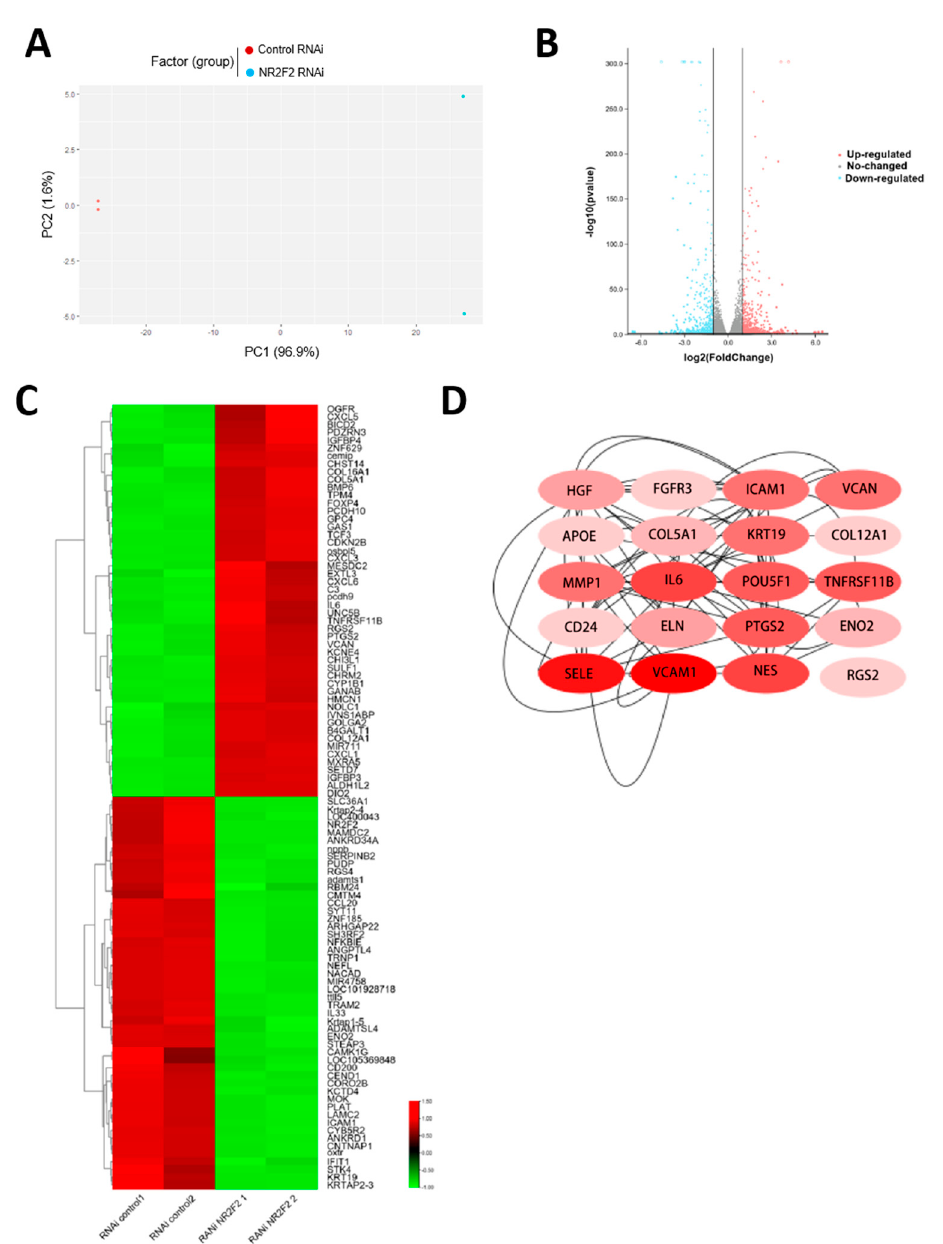
Figure 2. Global gene expression changes upon NR2F2 knockdown in WJ-MSCs. ( A ) WJ-MSCs exhibited two distinct gene expression patterns after NR2F2 was knocked down. ( B ) Each point in the volcano plot represents a gene. Red dots indicate significantly up-regulated genes, blue dots indicate significantly down-regulated genes, and grey dots indicate non-differentially expressed genes. ( C ) Heatmap showing the top 50 genes with the most significant up- and down-regulation, with red for up-regulation and green for down-regulation. ( D ) The darker the red of the Hub gene, the higher the score.